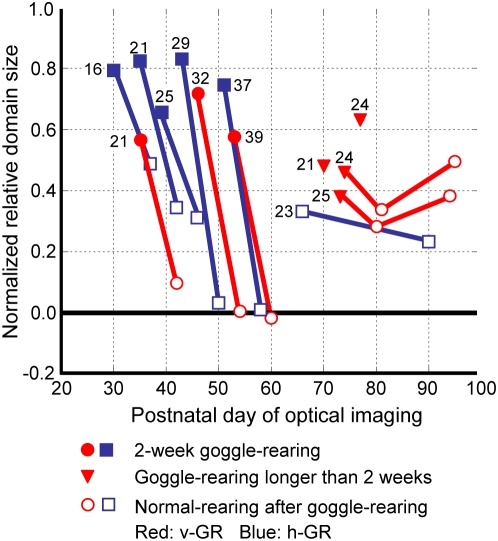
Effects of duration and timing of GR.The relative size of cortical domains preferentially responding to the exposed orientation is plotted against the postnatal day of optical imaging. Symbols are indicated in the figure. Plots obtained from identical kittens are linked by solid lines. Numerical figures indicate onset ages of GR.